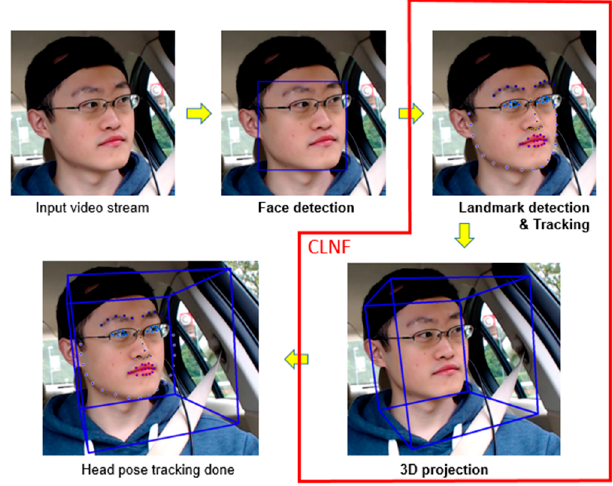
Figure 5. The process to measure head movement based on the camera-based head tracking